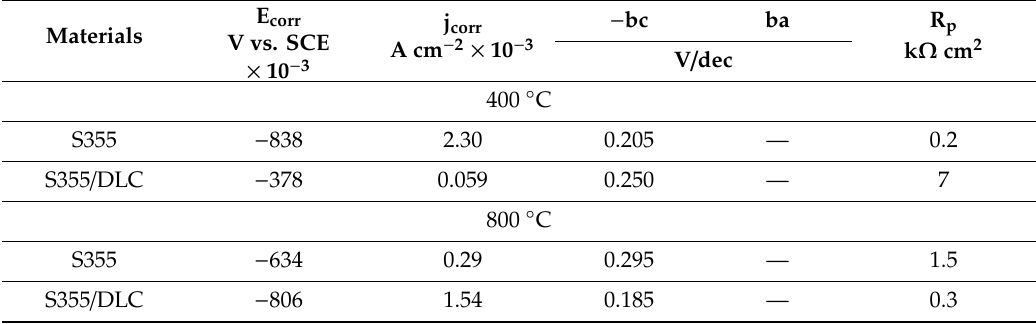
Table 3. Parameters of electrochemical corrosion, and polarization resistance for the S355 steel, with and without the diamond-like carbon coating, after heat treatment in air atmosphere at 400 and 800 ◦ C.